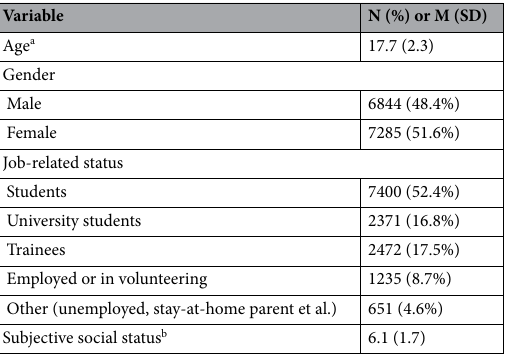
Table 1. Participant characteristics for the study sample (N = 14,129). a Age ranged from 14 to 21 years due to inclusion criteria. b MacArthur Scale 35,36 , ranging from 1 (low income, the worst jobs, the lowest education) to